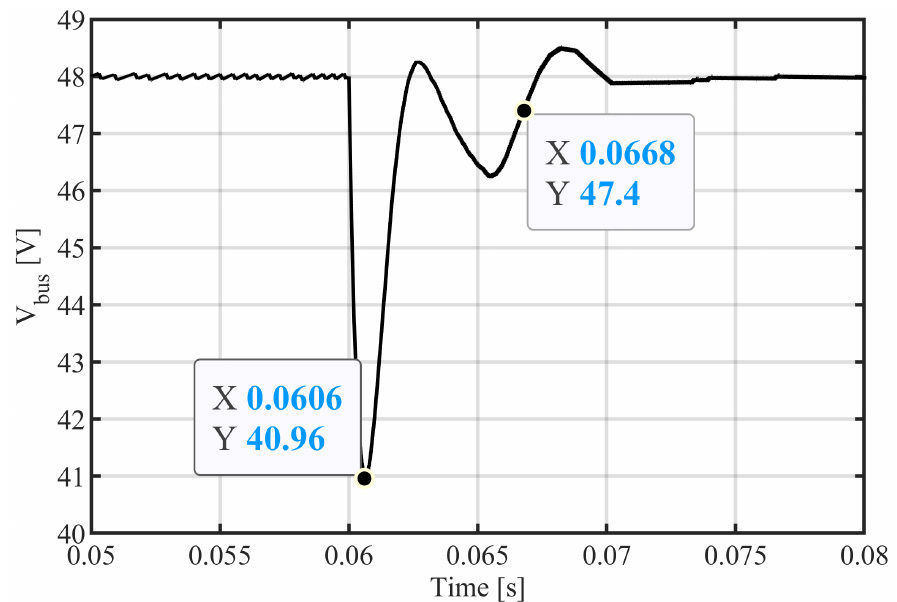
Figure 7. Simulation result with a load change from 36 to 9 Ω